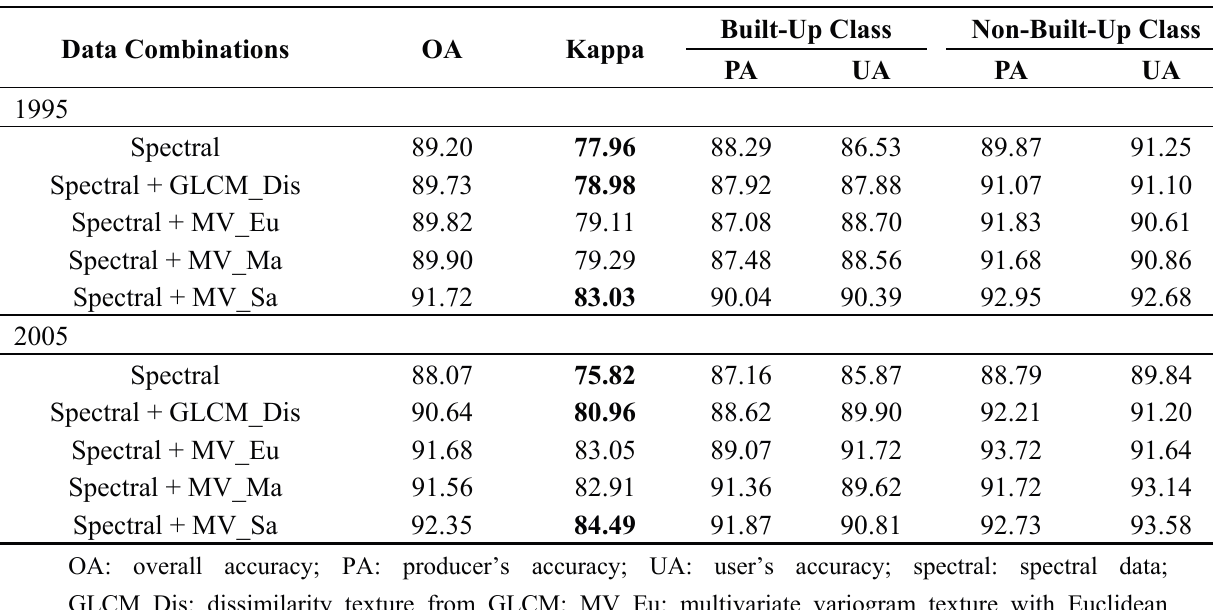
Table 4. Classification accuracies using multispectral data and texture features from Beijing images (all in